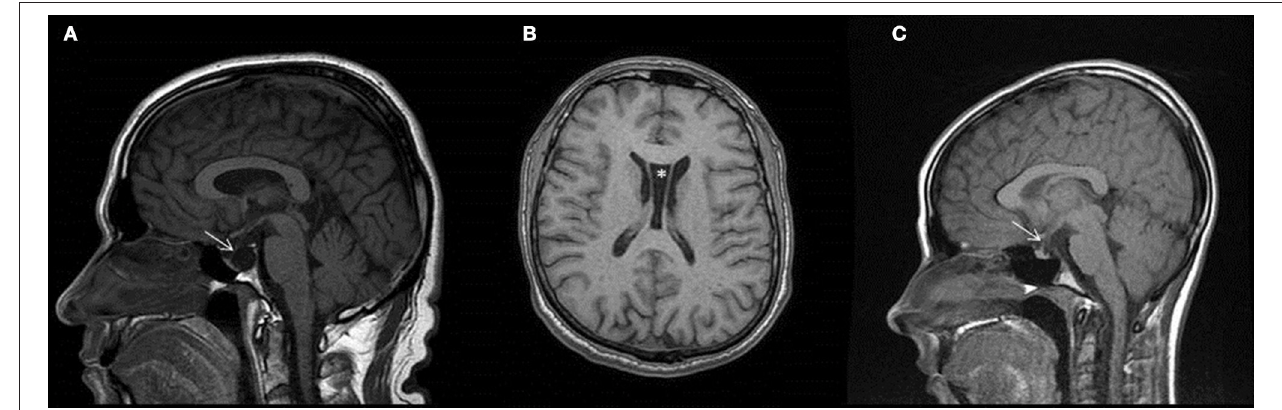
FIGURE 2 | Brain MR images of the examined patients. T1 weighted images of Patient II/2 (A,B) , and of Patient III/1 (C) . Image (A) and (C) demonstrate empty sella on sagittal images. Infundibulum sign is identifiable (arrows), thus proving empty sella vs. cystic mass of pituitary.